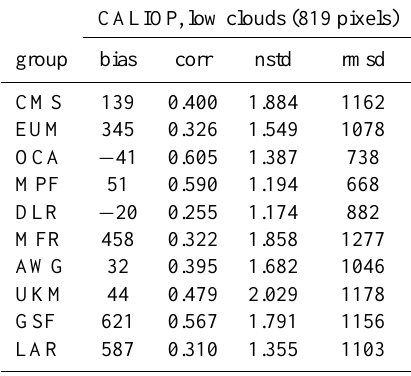
Table 11. Same as Table 6, but for clouds with a CALIOP CTH smaller than 3.25km only. Pixels are taken into account, for which all SEVIRI algorithms as well as the CALIOP retrieval pro- vide CTH values. This comparison is for 13 June 2008, 12:00– 15:30UTC. The mean CTH retrieved from CALIOP is 1806m and the standard deviation is 661m.